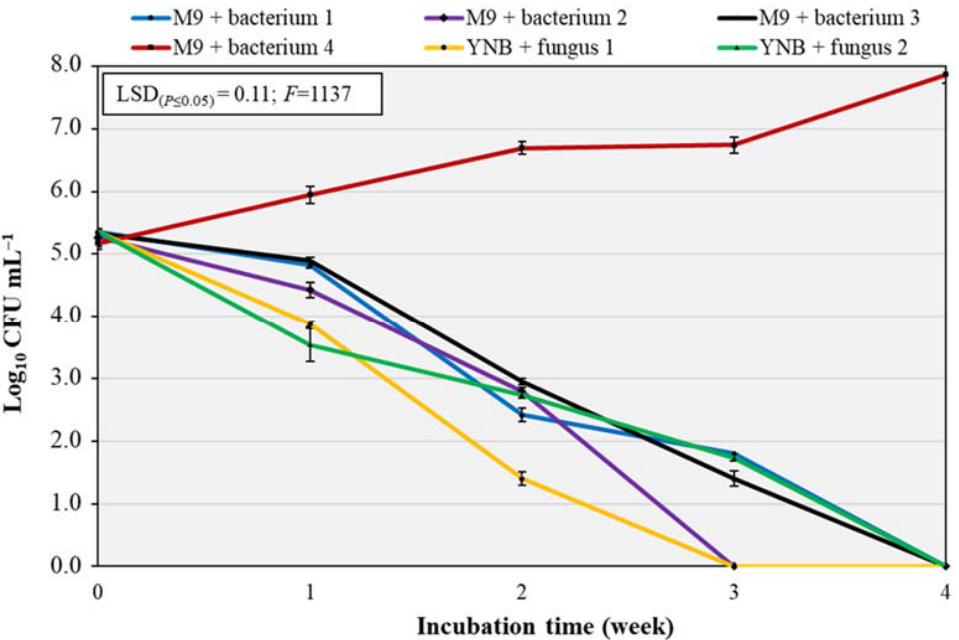
Figure 4. Population densities (log 10 CFU mL − 1 ) of the six isolated pure cultures in liquid media with BP samples as sole carbon source over four weeks. The Least Significant Difference (LSD) interaction was calculated with the Fisher’s protected LSD test at α = 0.05. Vertical bars indicate the standard deviation of the mean. F , F of Fisher.